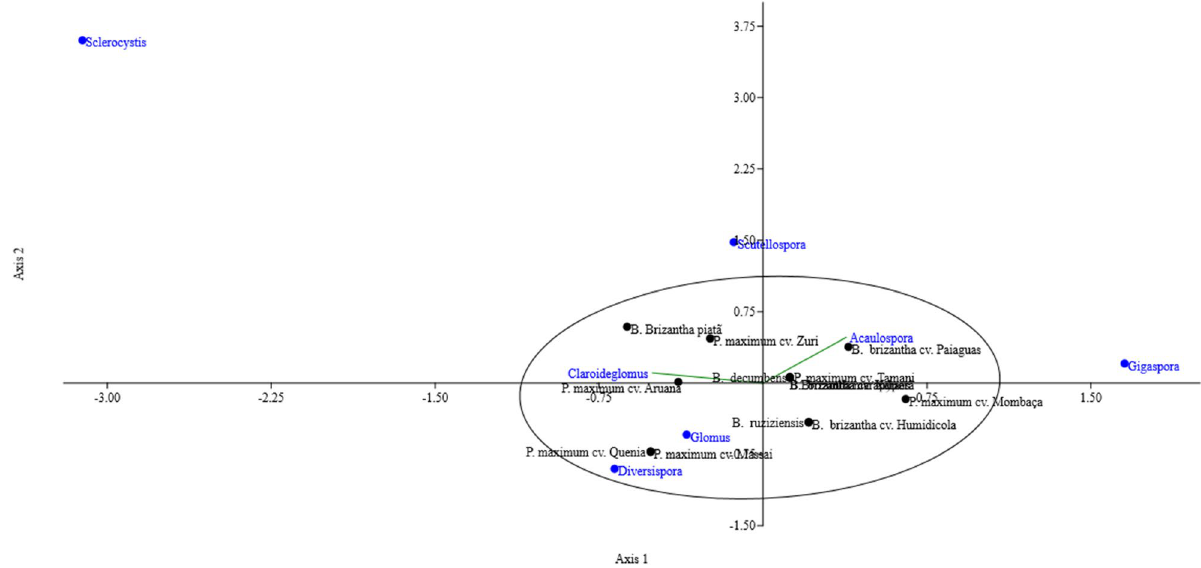
Figure 2. Canonical correspondence analysis of the associated genera found in rhizospheric soil of different forage grasses in cerrado